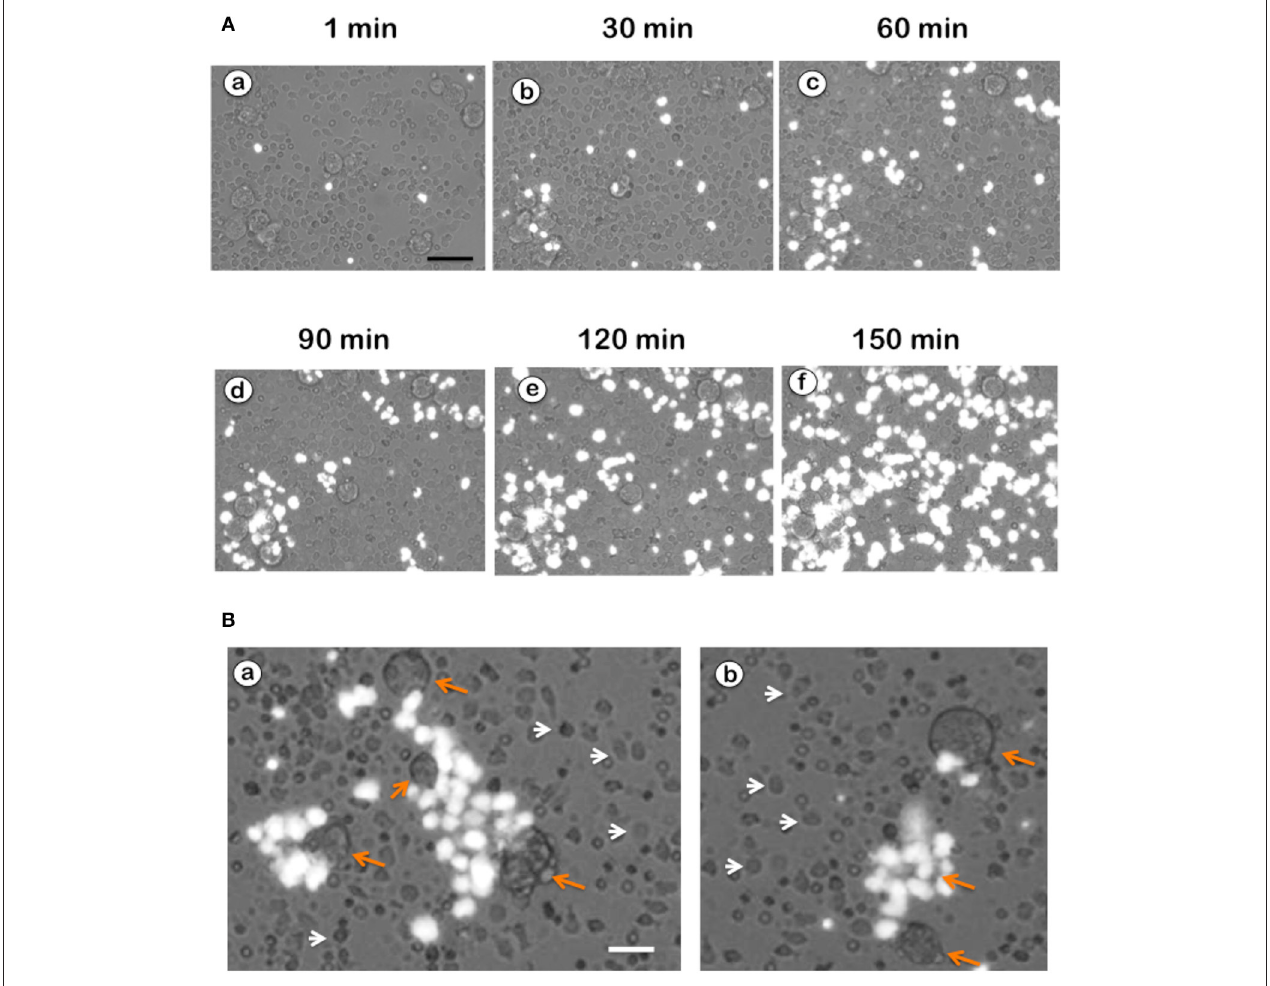
FIGURE 2 | Neutrophils in touch with Entamoeba histolytica release NETs. (A) Human neutrophils were stimulated with E. histolytica in the presence of SYTOX ® Green. Live cell images were captured at different times with a fluorescence inverted microscope. External DNA fluorescence appears bright white in the pictures. Scale bar is 50 µ m. (B) NETs formation was induced only in neutrophils that were in direct contact with E. histolytica trophozoites (orange arrows). The NETs were produced around the amoebas and progressively covered the parasites. Neutrophils that were not in contact with amoebas (white arrow heads) did not release DNA fibers and never became SYTOX ® Green-positive. Scale bar is 25 µ m.